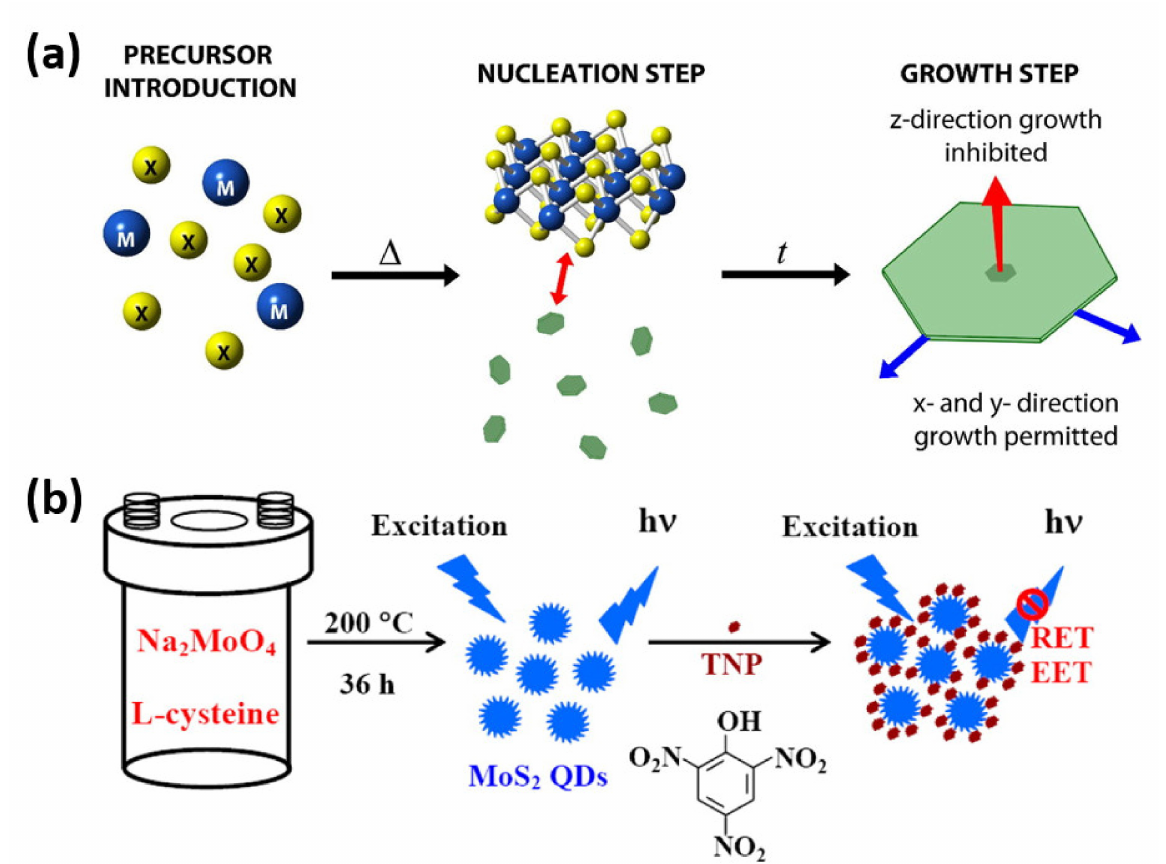
Figure 9. ( a ) Schematic representation of the growth of a nanosheet from molecular precursors [81]. ( b ) Hydrothermal route for the synthesis of photoluminescent MoS 2 quantum dots (QDs) by using sodium molybdate and cysteine as precursors [82]. Figure reproduced with permission from Elsevier and ACS